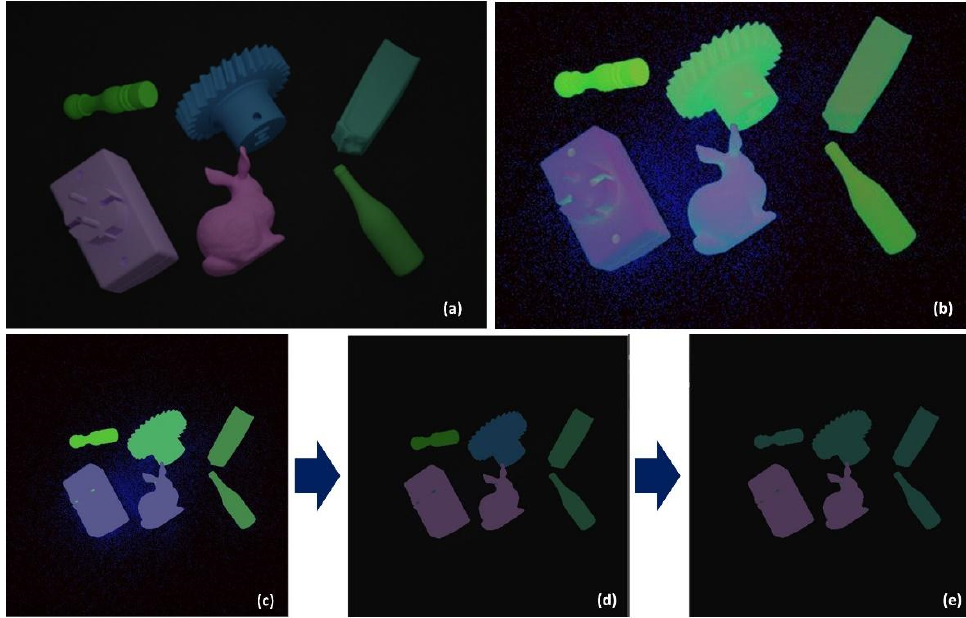
Figure 4. Converting the input image between BGR and HSV color spaces. ( a ) Image in BGR; ( b ) Image converted to HSV color space; ( c ) Applying K-means clustering on HSV image with 15 clusters. ( d ) Clustered image is converted to BGR space. ( e ) Applying K-means clustering on BGR image with three clusters.